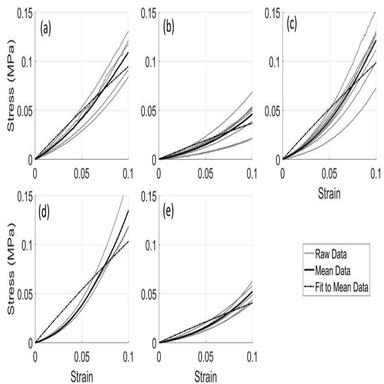
Circumferential tensile stress versus strain response for case 2 (a), case 3 (b), case 4 (c), case 8 (d), and case 9 (e). Mean and subsequent curve fit to the mean are also given.